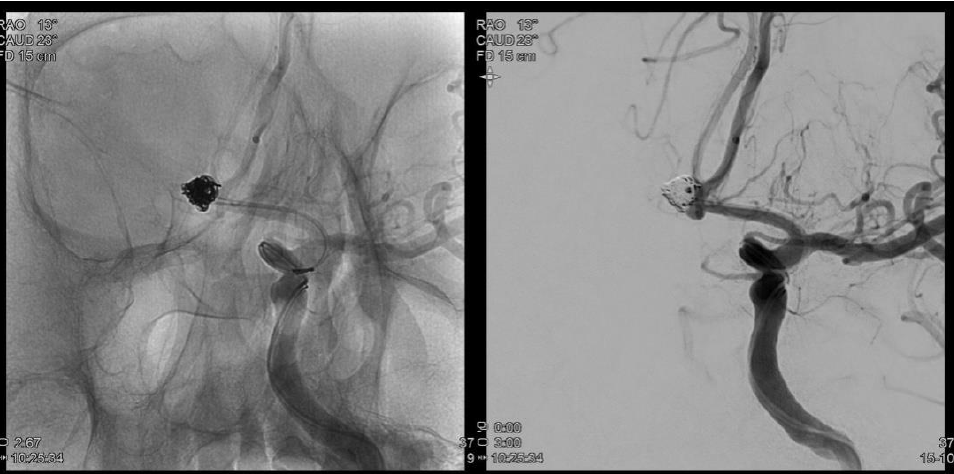
Figure 1. Trans femoral cerebral angiography images show a 6.2 mm sized AcomA (anterior communiating artery) aneurysm and AcomA aneurysm was embolized following coil procedure. The diagnosis was cilioretinal artery occlusion with branch retinal artery